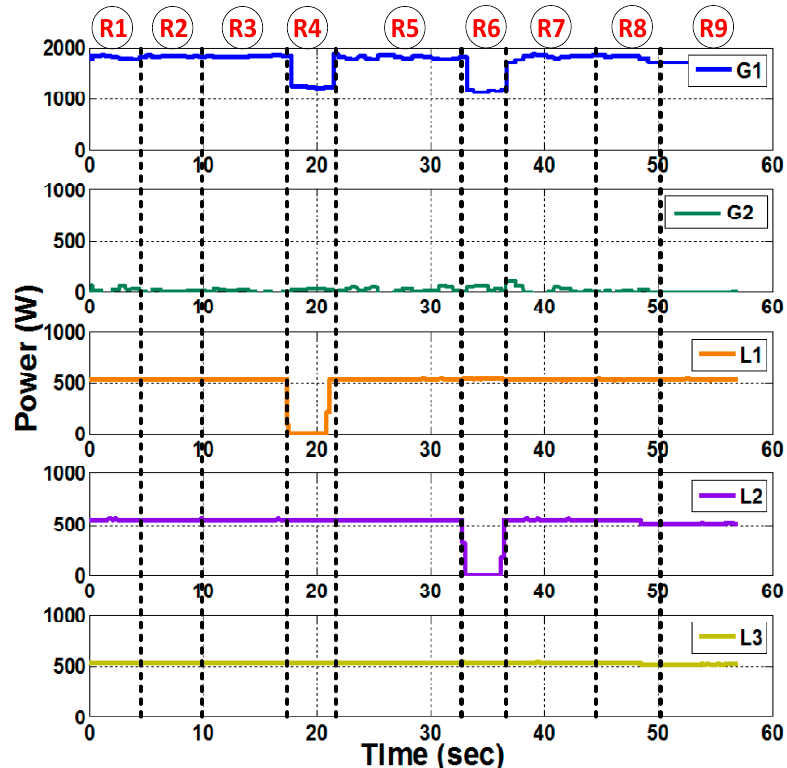
Figure 9. Power on each of the 5 buses of the studied power system. Each region (R1–R9) represents a different contingency case. Power drops in R4 and R6 indicate that the command to open the CB for L1 and L2, respectively, was passed by the agents. Table 4. Experimental Evaluation of the proposed security system.